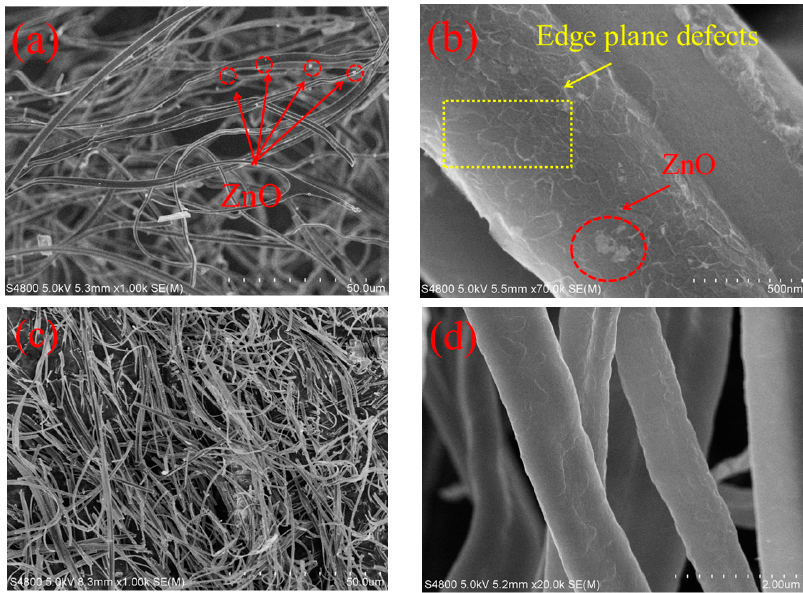
Figure 2. SEM image of ZCF and CF ( a ) surface morphologies of ZCF with 1 K magnification; ( b ) surface morphologies of ZCF with 70 K magnification; ( c ) surface morphologies of CF with 1 K magnification; ( d ) surface morphologies of CF with 20 K magnification.